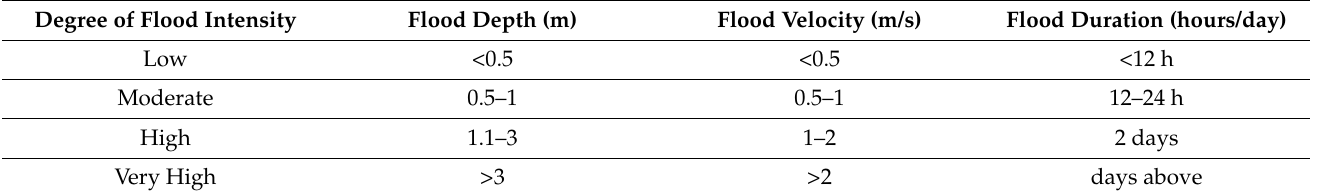
Table 7. Classification of indicators for flood hazard